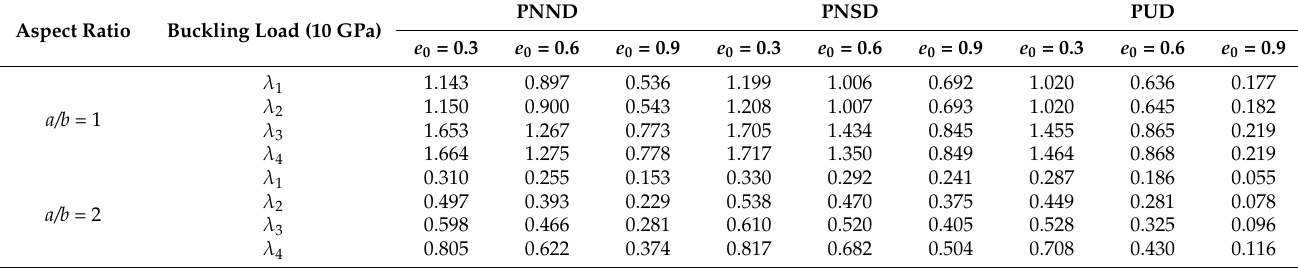
Table 4. First four shear buckling loads for a CFCF FG-saturated porous plate with different aspect ratios, a / b , porosity distributions and porosity coefficients, e 0 , keeping β = 0.6